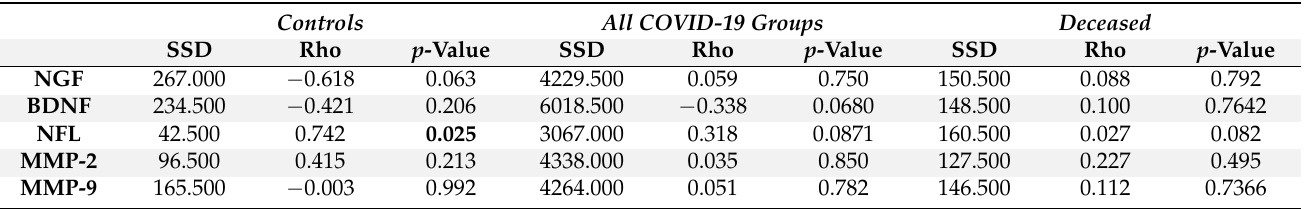
Table 3. Spearman correlation values for the age parameters in all groups. Significant scores are shown in bold.